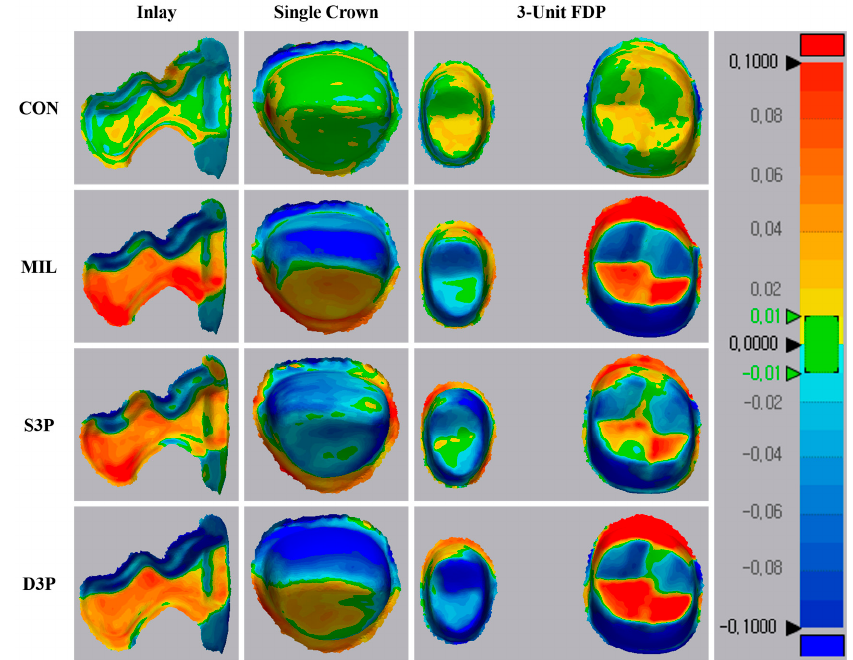
Figure 4. Qualitative analysis of trueness of prepared teeth in tested group. CON, conventional gypsum model; MIL, milled gypsum model; S3P, SLA 3D printed photopolymer model; D3P, DLP 3D printed photopolymer